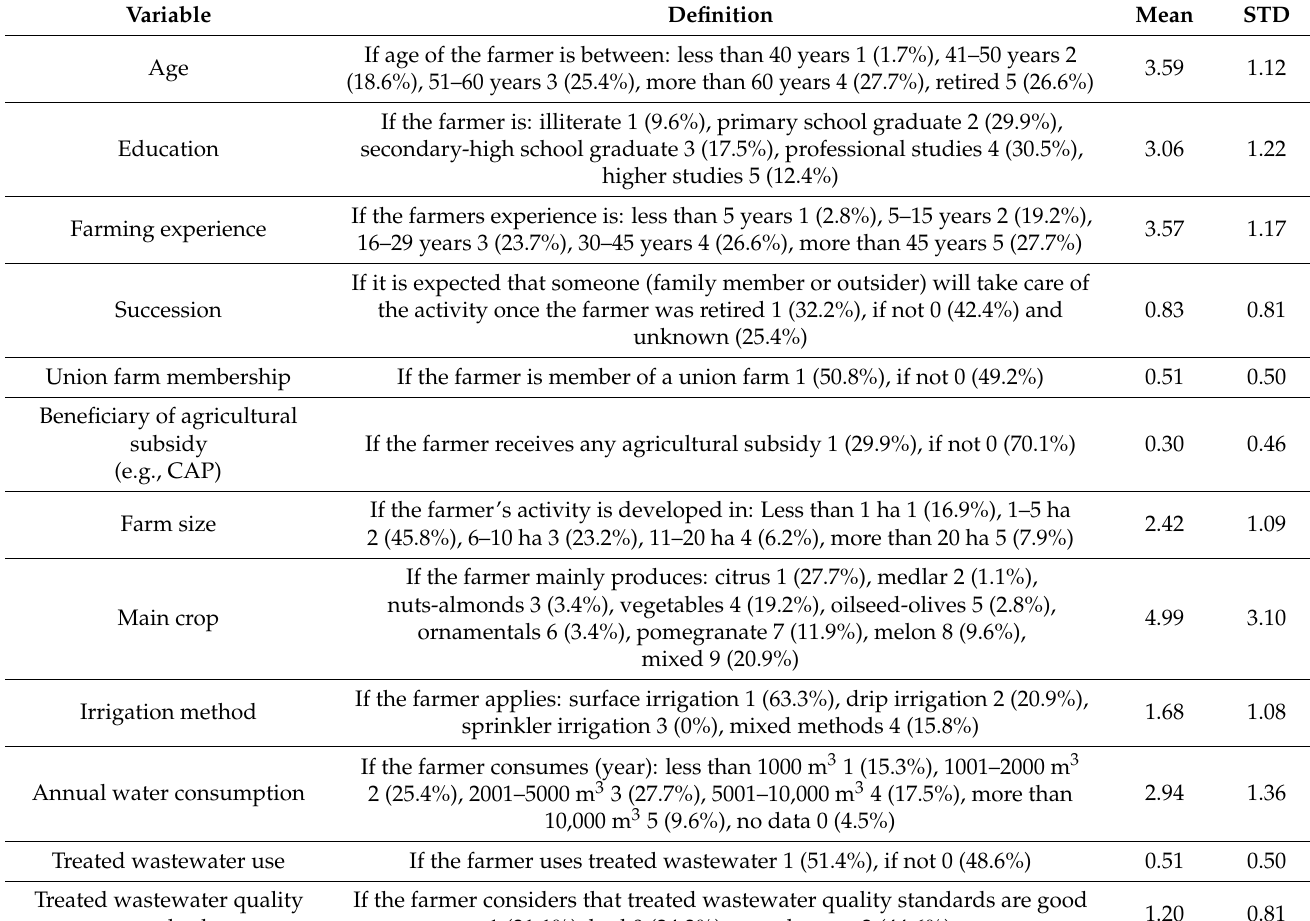
Table 2. Descriptive statistics of farmers’ sociodemographic profile.